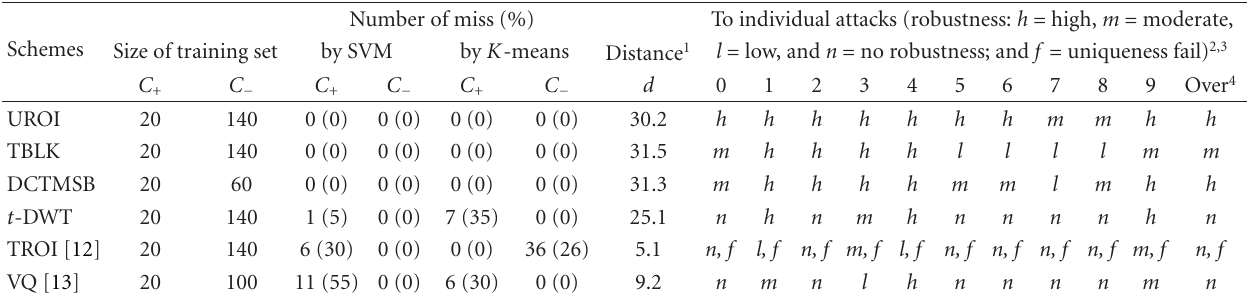
Table 9: Results and decisions for di ff erent approaches of the proposed MSB-based scheme and existing TROI-based [12] and VQ-based [13] schemes by the support vector machines (SVM) [27] and K -means clustering algorithm[28]. Number of miss (%) To individual attacks (robustness: h = high, m = Schemes